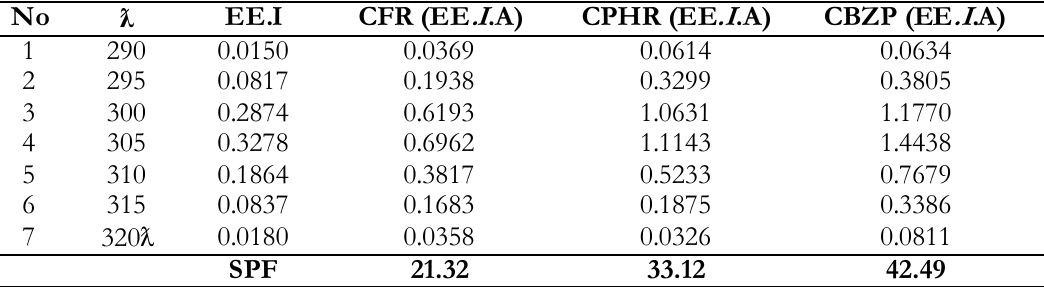
Table IV. SPF o/w cream on the CFR, CPHR and CBZP